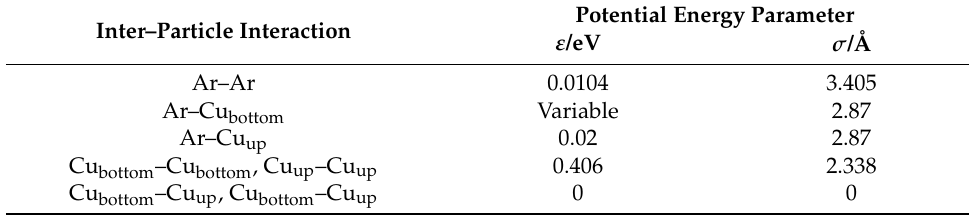
Table 1. Potential energy